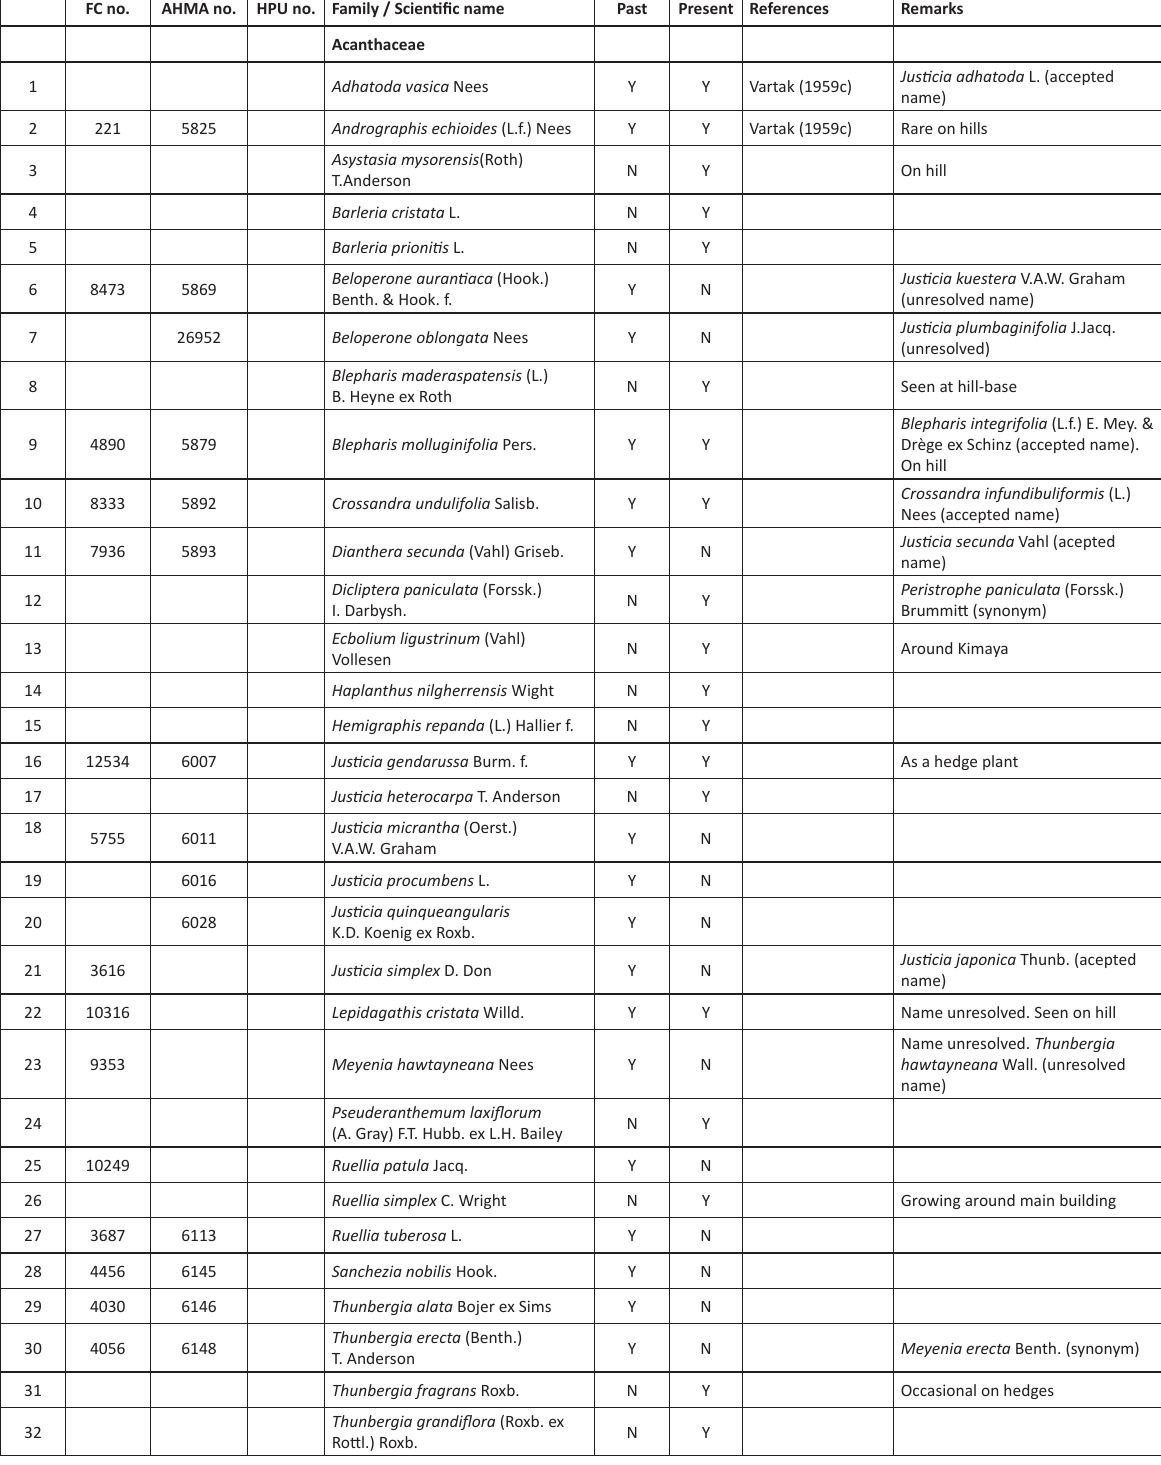
Table 1. Checklist of the vascular plants recorded in the campus till 2014. All scientific and family names follow The Plant List (2014). For each species, occurrence record from three herbarium sources namely herbarium of Agharkar Research Institute (AHMA), herbarium of Botany department, Fergusson College, Pune (FC*) and herbarium of Botany department, Pune University, Pune (HPU*) have been mentioned. The past and present status has been indicated by either Y (present) or N (absent).*-not standard acronyms. Records of only completely identified specimens have been included here except in cases where either the taxon is not reported by other sources or it is ascertained that the two taxa are different species. FC